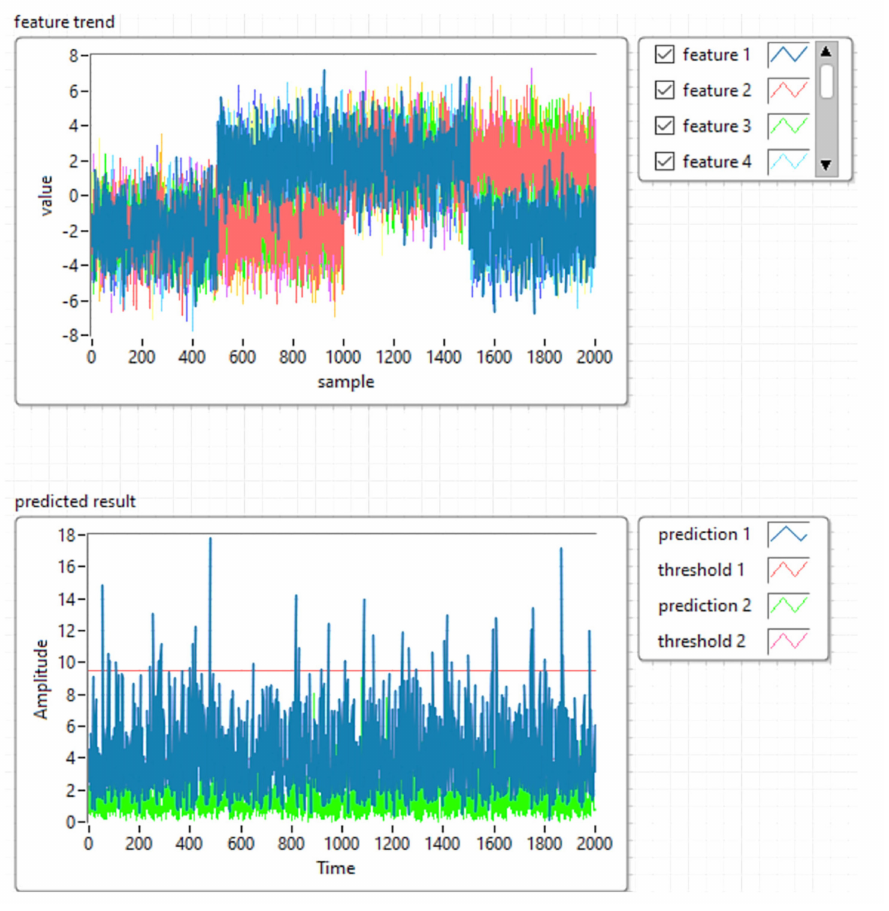
Figure 14. Results of the training templates using PCA T 2